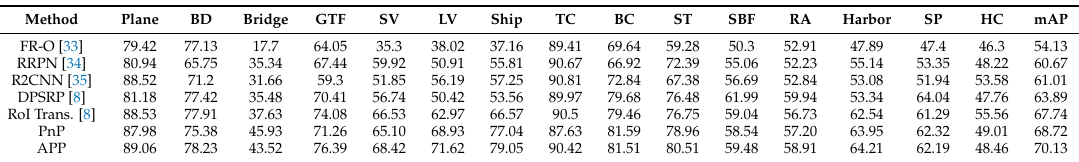
Table 5. Comparisons with state-of-the-art detectors on DOTA. There are 15 categories, including Baseball diamond (BD), Ground track field (GTF), Small vehicle (SV), Large vehicle (LV), Tennis court (TC), Basketball court (BC), Stor- age tank (ST), Soccer-ball field (SBF), Roundabout (RA), Swimming pool (SP), and Helicopter (HC) [8].